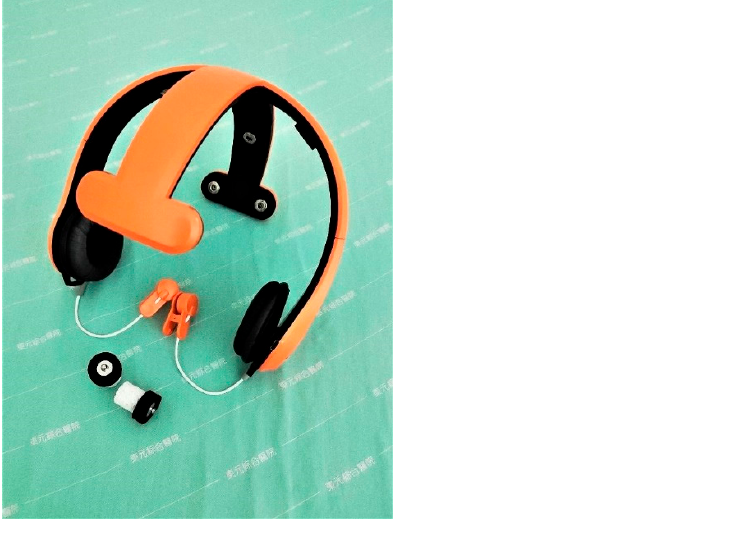
Figure 3. Wireless EEG device. A wireless and wearable EEG headset ( top ) and novel hygroscopic sponge electrodes ( bottom ). The sensors can be easily and quickly assembled, and fit appropriately into the original